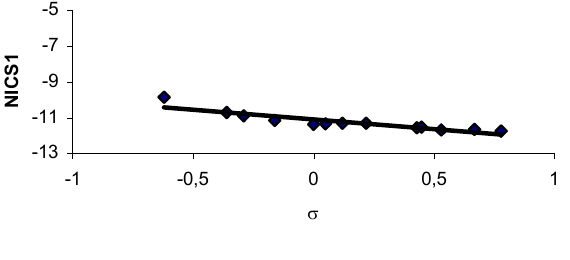
Figure 1 Dependences of σ substituent constants on NICS (r=-0.905) for p- substituted